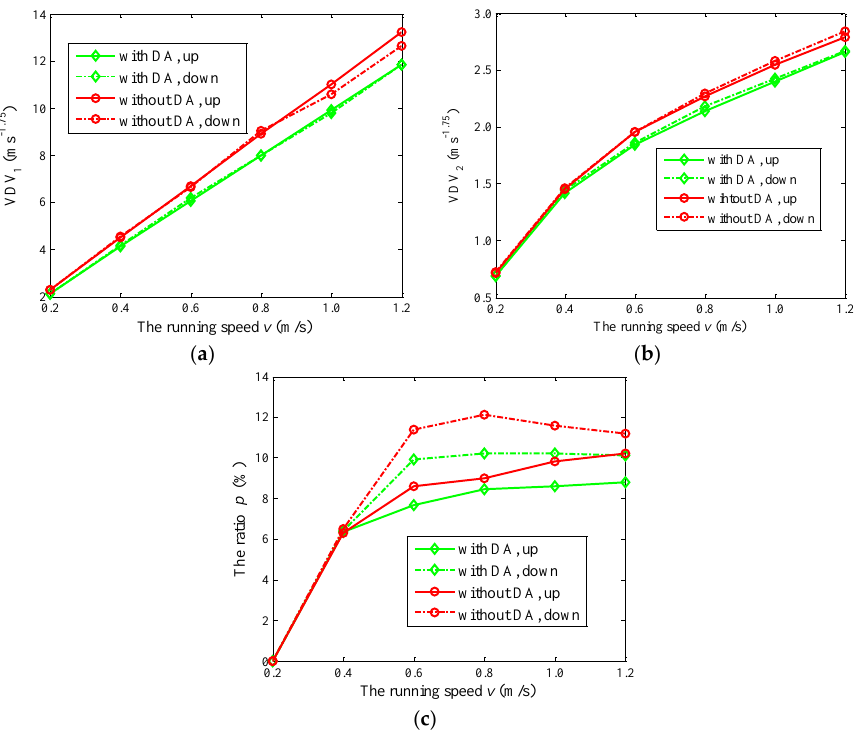
Figure 5. A comparison of the vibration behaviors of the human-wheelchair system with the dynamic absorber (DA) and without the DA undergoing the step: ( a ) VDV 1 versus v ; ( b ) VDV 2 versus v ; ( c ) p versus v .